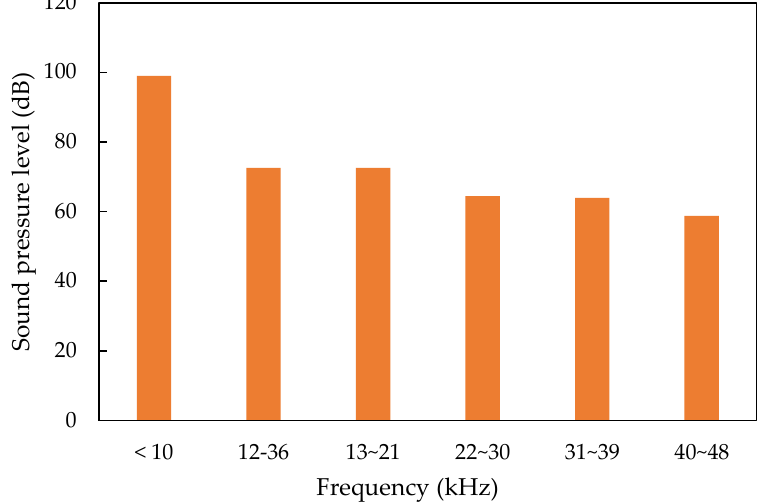
Figure 14. The sound pressure level of the TDMA and FDMA channels.